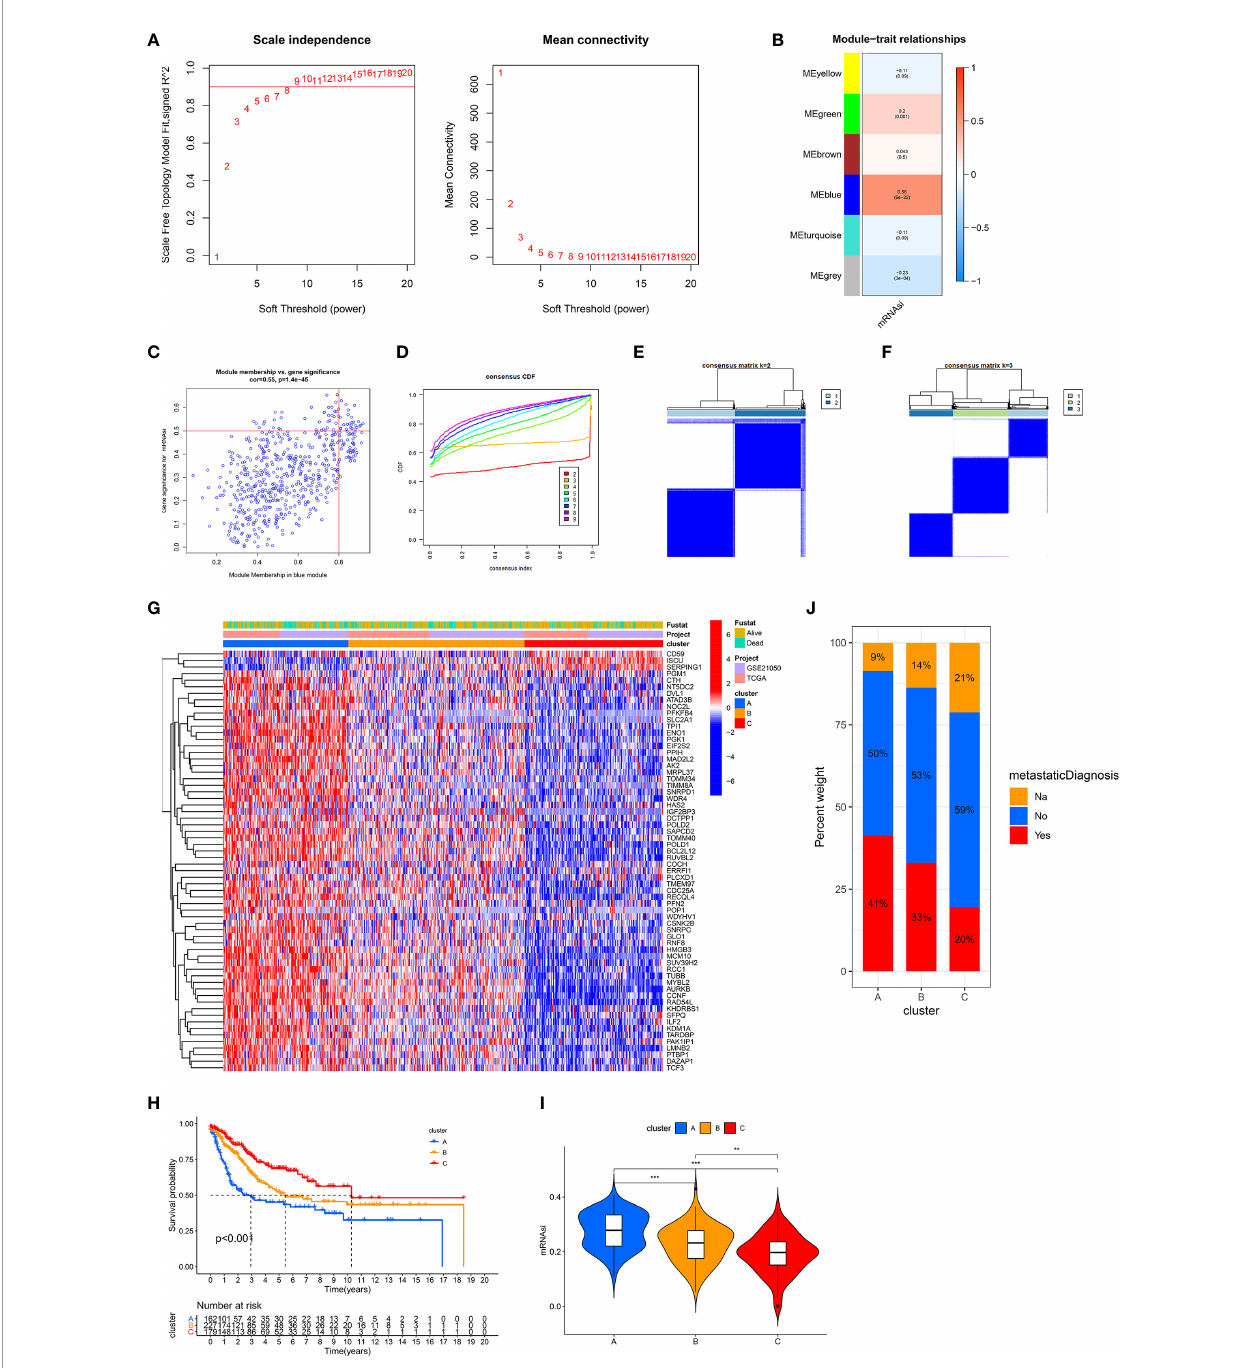
FIGURE 2 | Identi fi cation of three stemness subtypes based on prognostic SRSs. (A – C) Identi fi cation of SRSs based on WGCNA. (A) Selection of the optimal soft threshold power, b (optimal b = 8, R 2 = 0.9). (B) Heatmap of the module – trait relationship. Six modules were identi fi ed and related to clinical traits. The color depth of each cell represents the correlation between the module and mRNAsi, and the numbers in the cell represent the correlation coef fi cients and p value, respectively. (C) Identi fi cation of genes with high signi fi cance and module membership in the mRNAsi-related blue module. (D – F) Consensus clustering (K-means) algorithm was performed for overall patients. (C) CDF plot. The fl atter the middle part of the curve, the better the clustering effect. (E, F) Consensus matrix plots. K = 3 was determined as optimal clustering number. (G) Heatmap of the gene expression of prognostic SRSs among three stemness subtypes (clusters A, B, and C). (H) K – M survival analysis in clusters A, B, and C. (I) The differences of mRNAsi among clusters A, B, and C. (J) The percentage of metastatic and non-metastatic patients. Na: data were not available. ***p < 0.001; **0.001 < p <